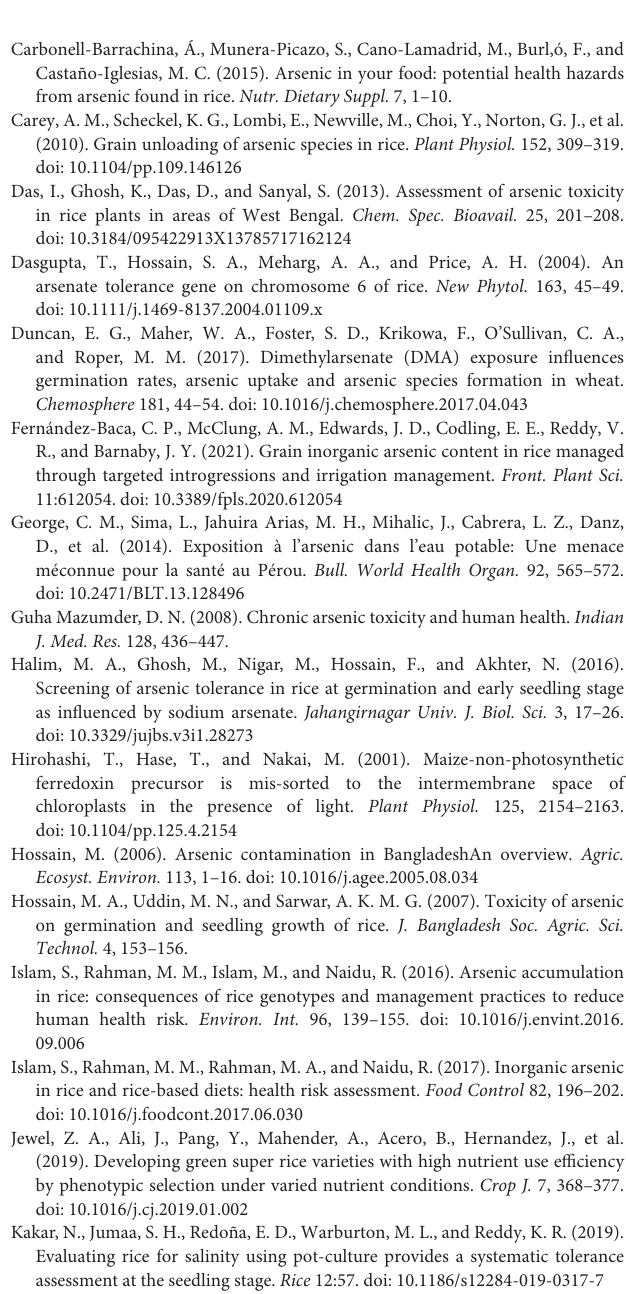
Supplementary Figure 1 | Heat map showing the Pearson correlation coefficient value of As-related traits. RCC, relative chlorophyll content; RPH, relative plant height; RRL, relative root length; RSBM, relative shoot biomass; RRBM, relative root biomass; ShAsC, As content in shoots; RtAsC, As content in roots; GrAsC,